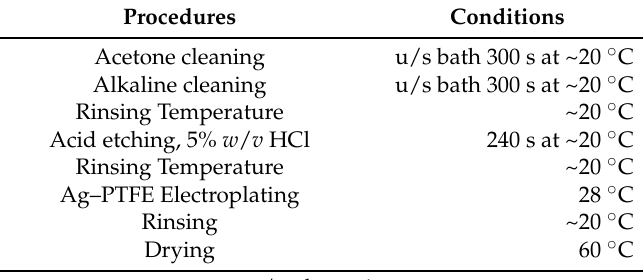
Table 2. Sample pre-treatment prior to plating.